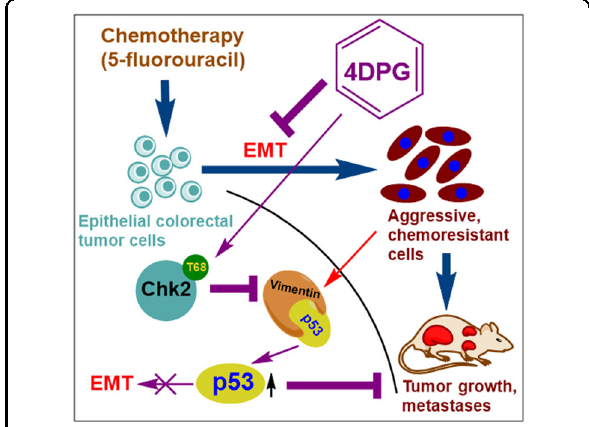
Fig. 5 Schematic representation depicting the proposed mechanism of action of 4DPG. Epithelial CRC cells exposed to chemotherapeutic agents (5-FU) undergo EMT and transform into mesenchymal phenotypes. On the other hand, 4DPG treatment activates tumor-suppressor protein, Chk2, represses Vimentin, and disrupts Vimentin – p53 association in aggressive 5-FU-R CRC cells. This role of 4DPG further rescues/augments p53, suppresses EMT, and CRC